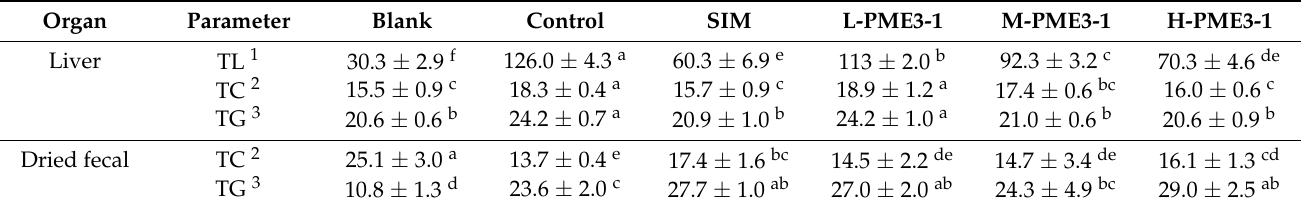
Table 5. Effects of PME3-1 on lipids and cholesterol content of the liver tissue and fecal in high fat and cholesterol diet in